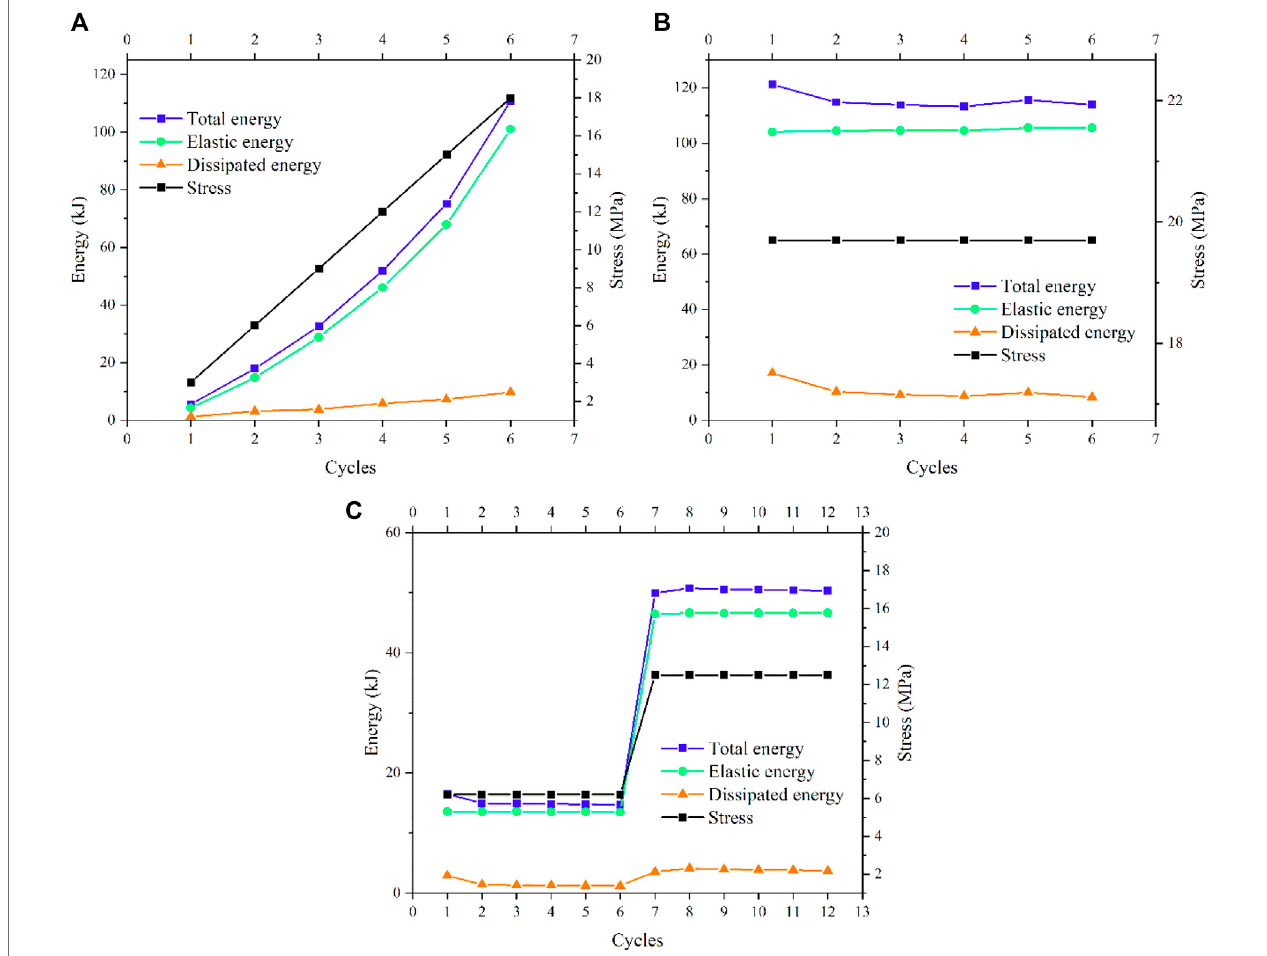
FIGURE11| Energy evolution diagram ofeach cycle for differentloadingmodes. (A) Increased amplitudecycle loading; (B) Constant amplitude cyclic loading; (C) Section cycle loading.